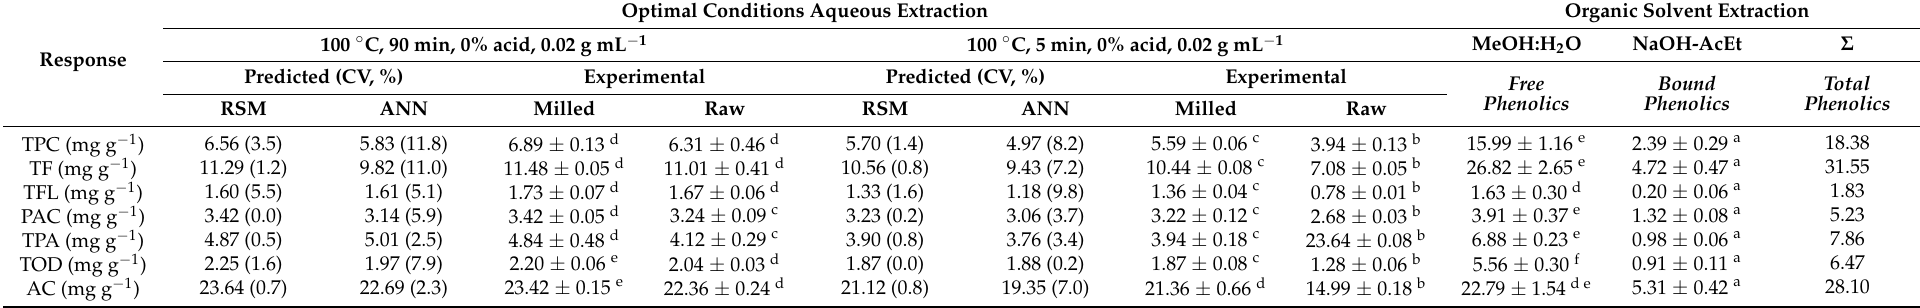
Table 5. Validation of predicted values at optimal conditions of the aqueous extraction and comparison with organic solvent extraction of the phenolic compounds from the coffee husk.